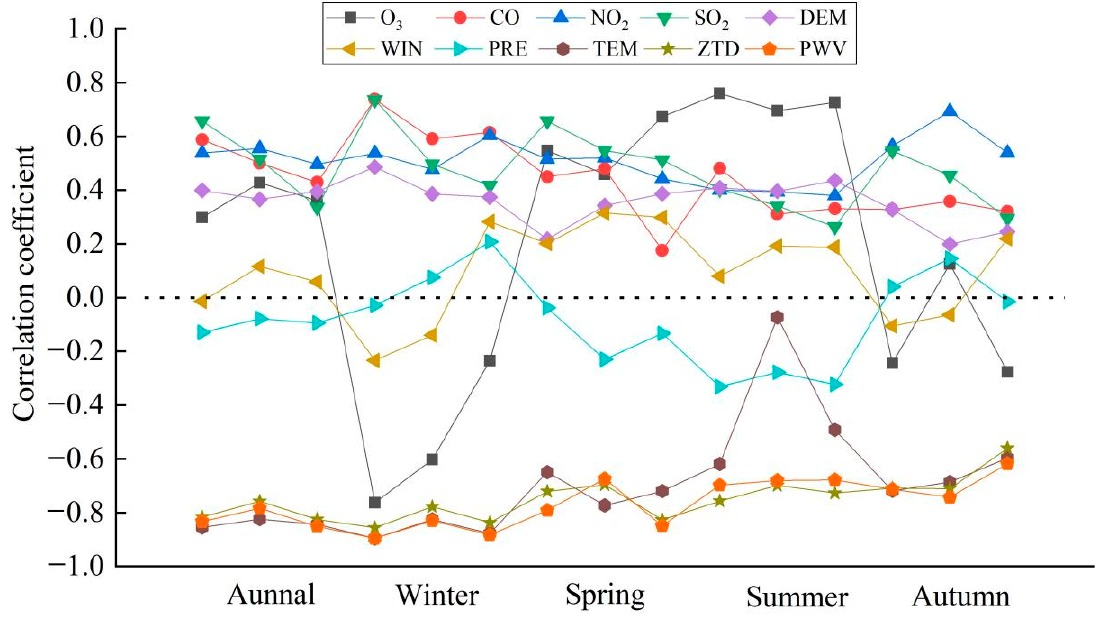
Figure 8. Spearman’s correlation coefficient.